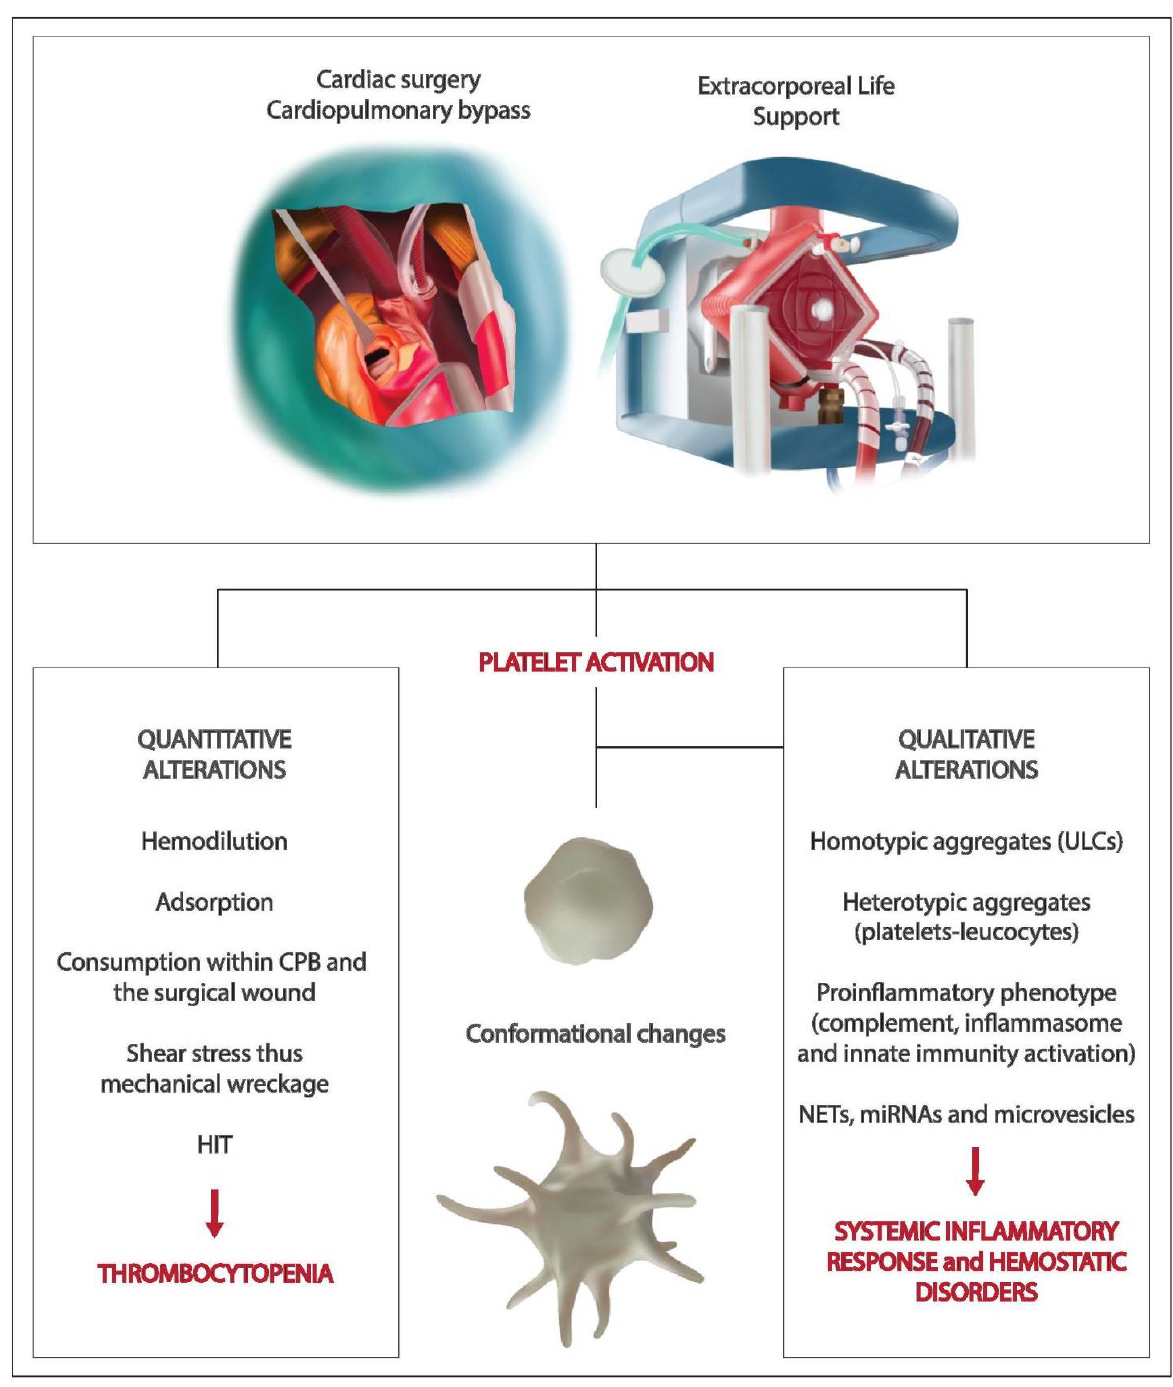
Figure 1. Platelet activation as a consequence of cardiopulmonary bypass-assisted cardiac surgery and extracorporeal life support. A summary of quantitative and qualitative platelet derangements. Abbreviations: cardiopulmonary bypass (CPB), heparin-induced thrombocytopenia (HIT), ultra-large antigenic complexes (ULCs), neutrophil extracellular traps (NETs), microRNAs (miRNAs).